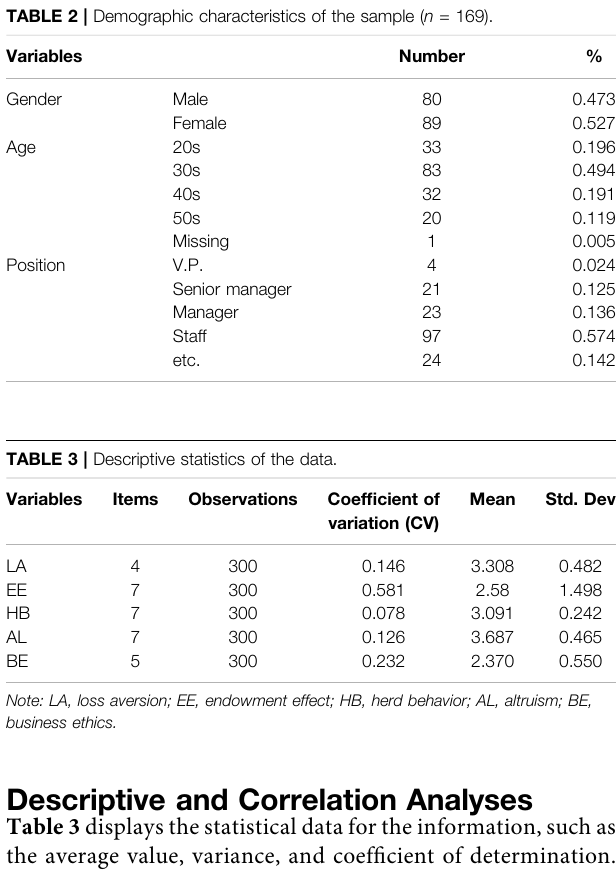
TABLE 4 | Correlation and discriminant validity